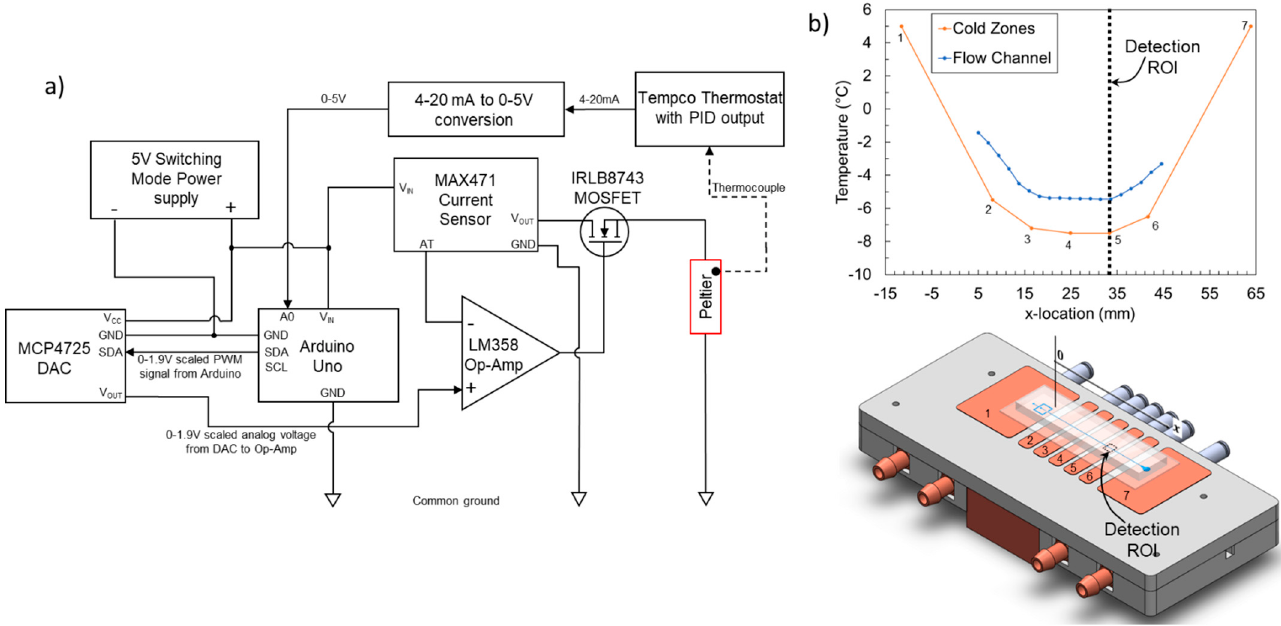
Figure 2. ( a ) Custom designed control circuit for the temperature-controlled platform ( b ) Cold zone temperatures measured using thermocouples and microfluidic channel temperatures measured using on-chip thin film sensors. The number labels next to the orange line indicate the corresponding cold zone in the schematic, and the temperature values are measured using thermocouples inserted into the copper blocks. The blue line indicates the temperature in the flow channel. Also shown is the location of the detection region of interest (ROI) during droplet freezing experiments.